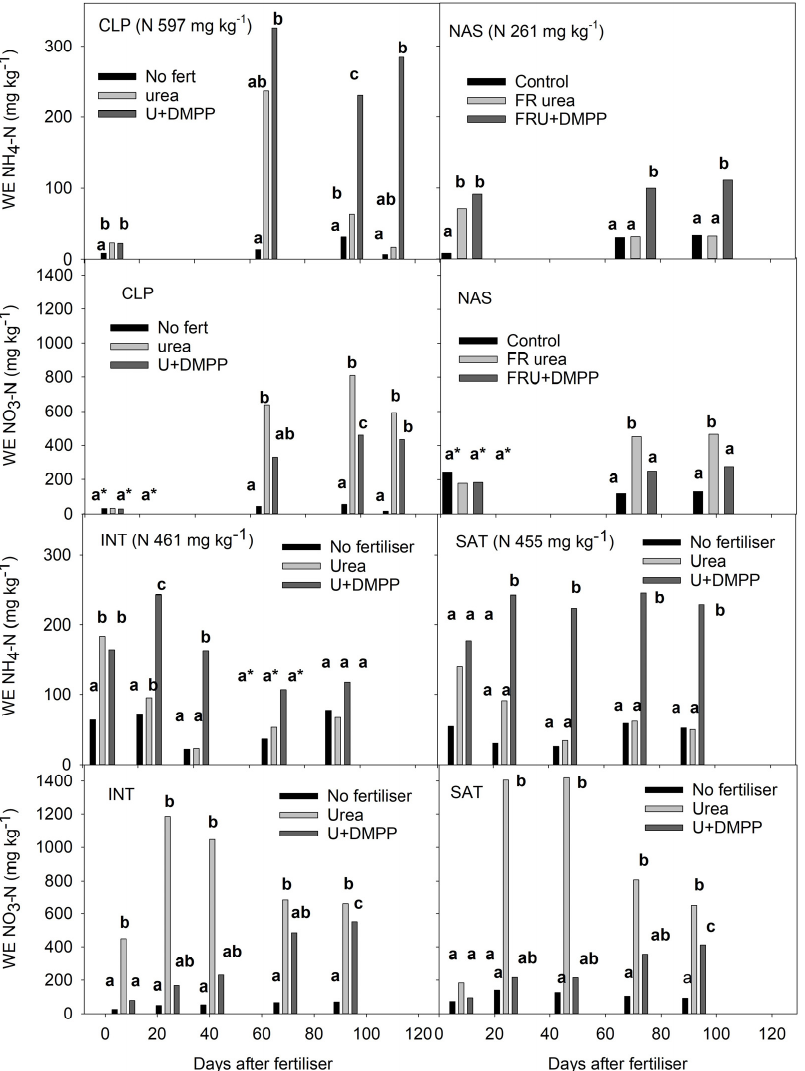
Figure 2. Water extract 2M KCl-extractable NH 4 -N and NO 3 -N (shown as WE NH 4 -N and WE NO 3 -N, respectively) in soil from root exclusion cylinders fertilized with urea, DMPP-coated urea (U+DMPP), or unfertilized (control) at CLP and NAS in 2016–2017, and at INT and SAT in 2017–2018. Rate of urea N banded into soil within root exclusion cylinders is given in brackets. Bars within each treatment with the same letters are not significantly different ( p > 0.05). Asterisks indicate that results for the pairwise comparison are not reliable (power of performed test <0.80). In the 2016/17 season, at 10 and 66 days after applying urea at CLP (8 days only at NAS), the concentration of 2M KCl-extractable NH 4 -N in soil (no water pre-treatment) was significantly higher than in water extracts (water pre-treatment; Table 3). These ob- servations suggest some of the fertilizer N had bound to soil mineral exchange sites. Coat- ing urea with DMPP delayed the release of exchangeable NH 4 -N (positive values in Table 3) There was no evidence of exchangeable NO 3 -N (water extract NO 3 -N higher than or